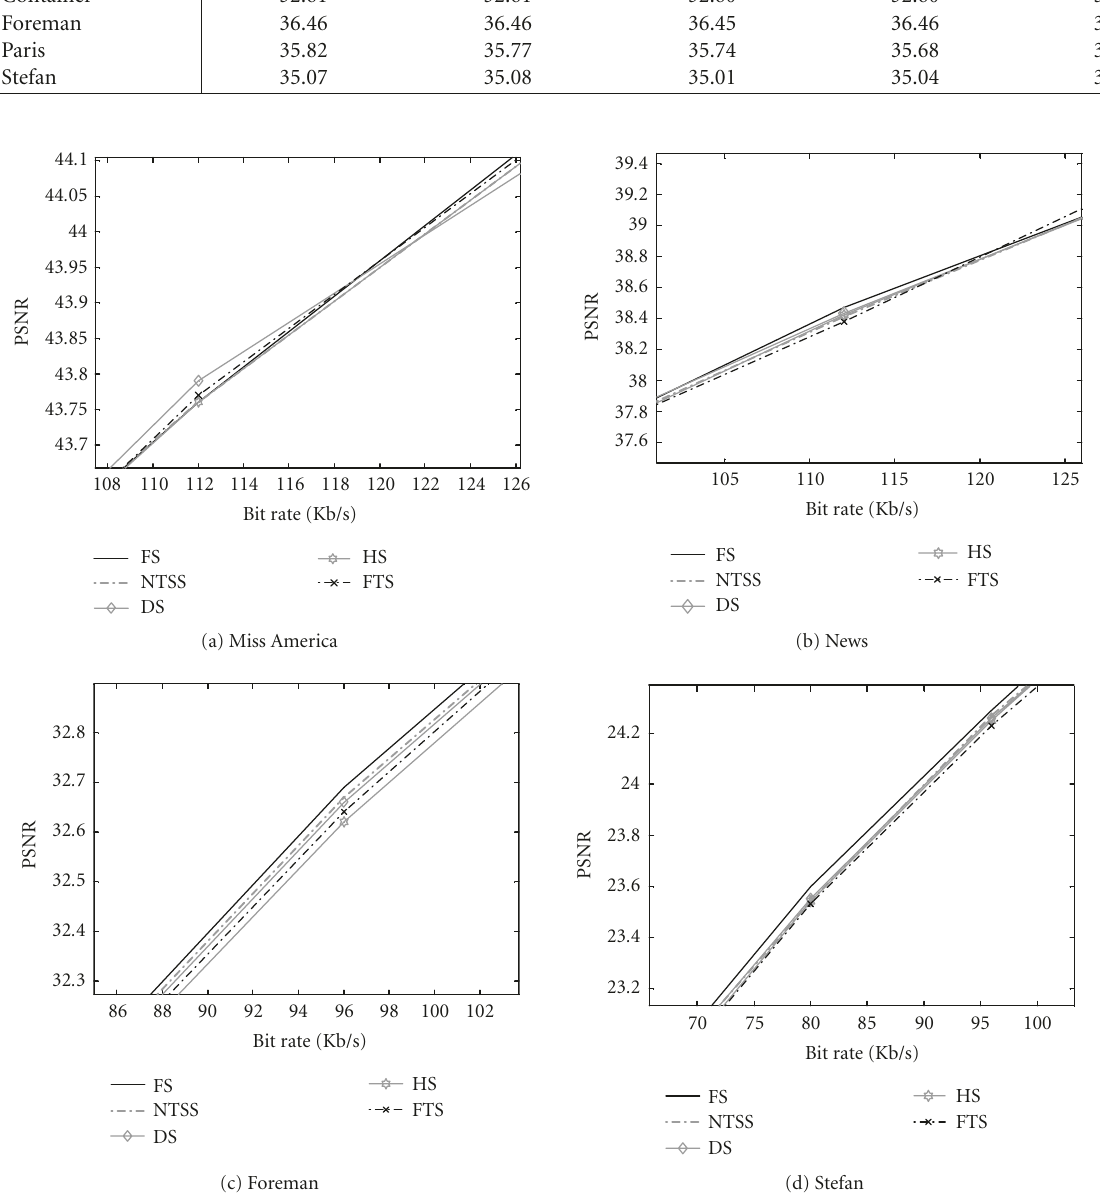
Figure 6: PSNR versus bit